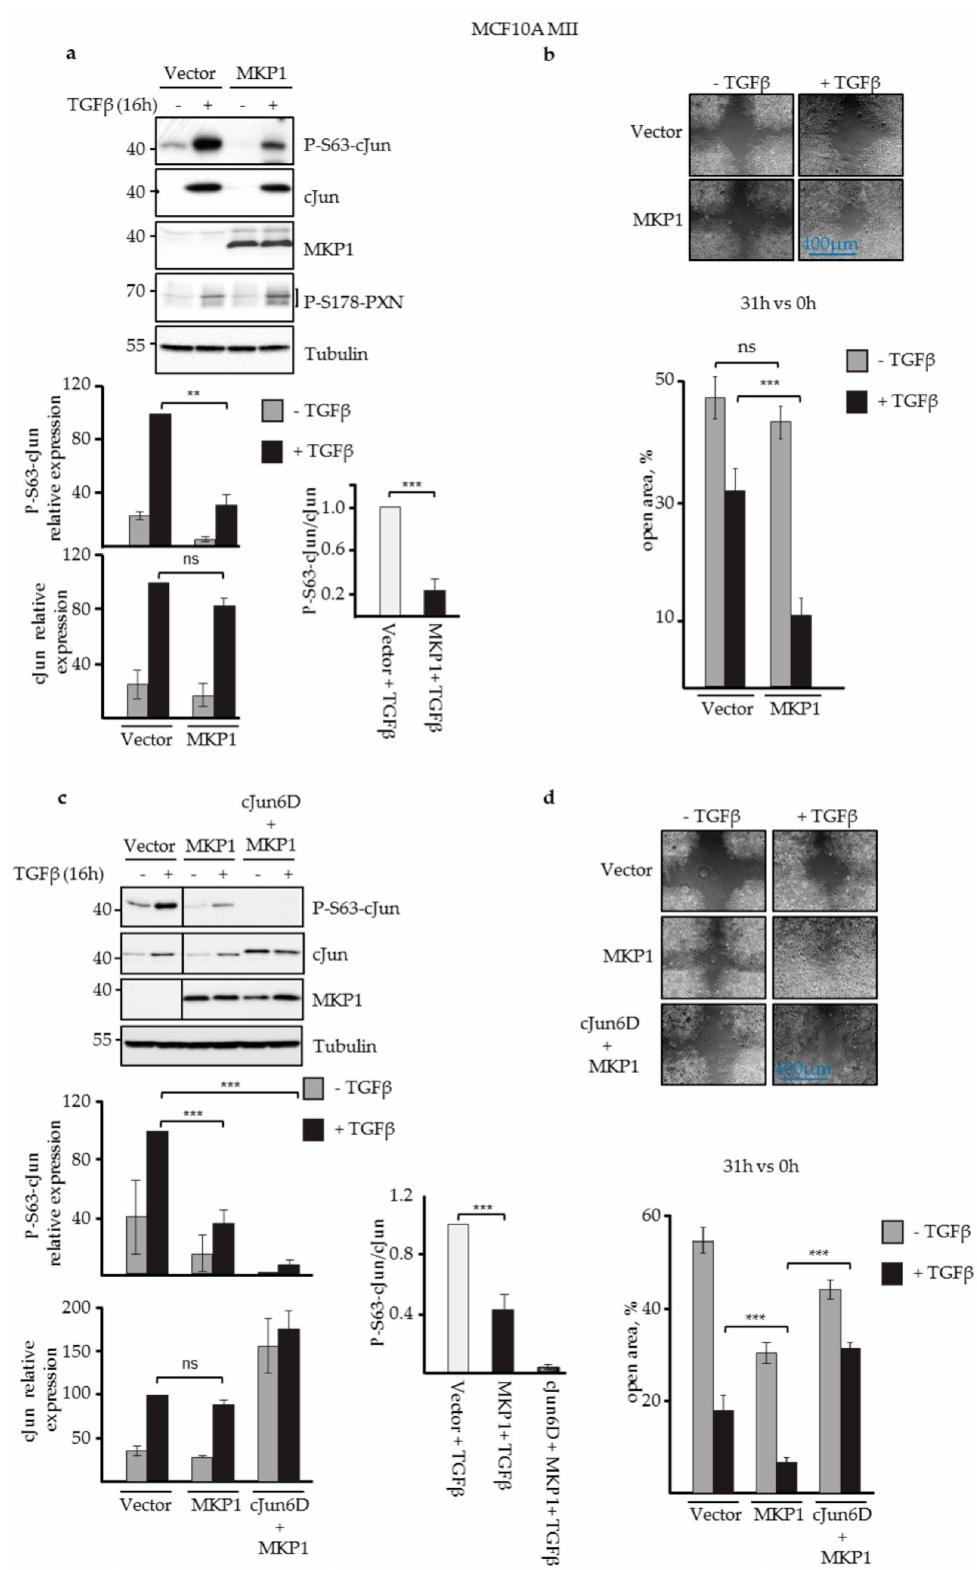
Figure 2. JNK-specific MKP1 inhibited cJun phosphorylation and enhanced MCF10A MII cell migration. ( a ) Immunoblot analysis of P-S63-cJun, cJun, MKP1, and P-S178-paxillin (PXN) levels upon stable lentiviral overexpression of JNK-specific MKP1 in MCF10A MII cells and treatment with 5 ng / mL TGF